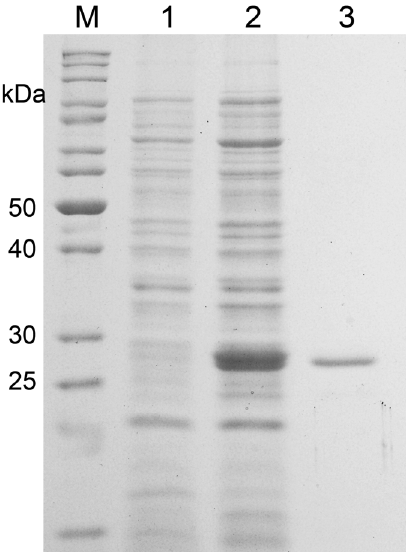
1. SDS–PAGE profile of the purified recombinant MnSOD47 enzyme. Lanes: M, standard protein marker; 1, MnSOD47 before induction with